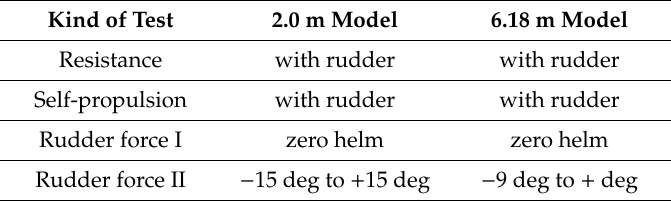
Figure 11. Large (6.18 m) ship model tested in 400 m towing tank. Table 5. Model tests conducted with two scaled Table 4. Principal dimensions of ship and models.